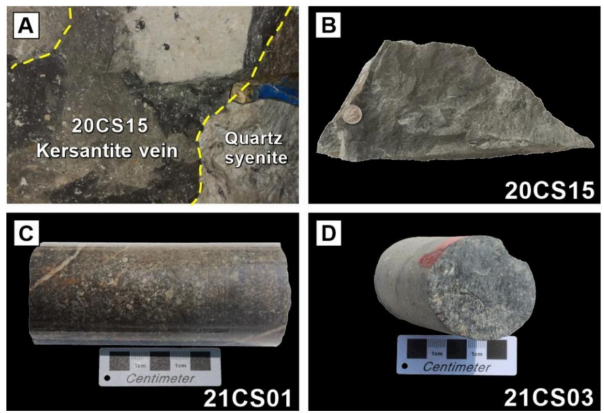
Figure 3. Field and hand-specimen photographs of the lamprophyres. ( A ) Kersantite vein; ( B ) ker- santite; ( C ) damkjernite; ( D ) spessartite.